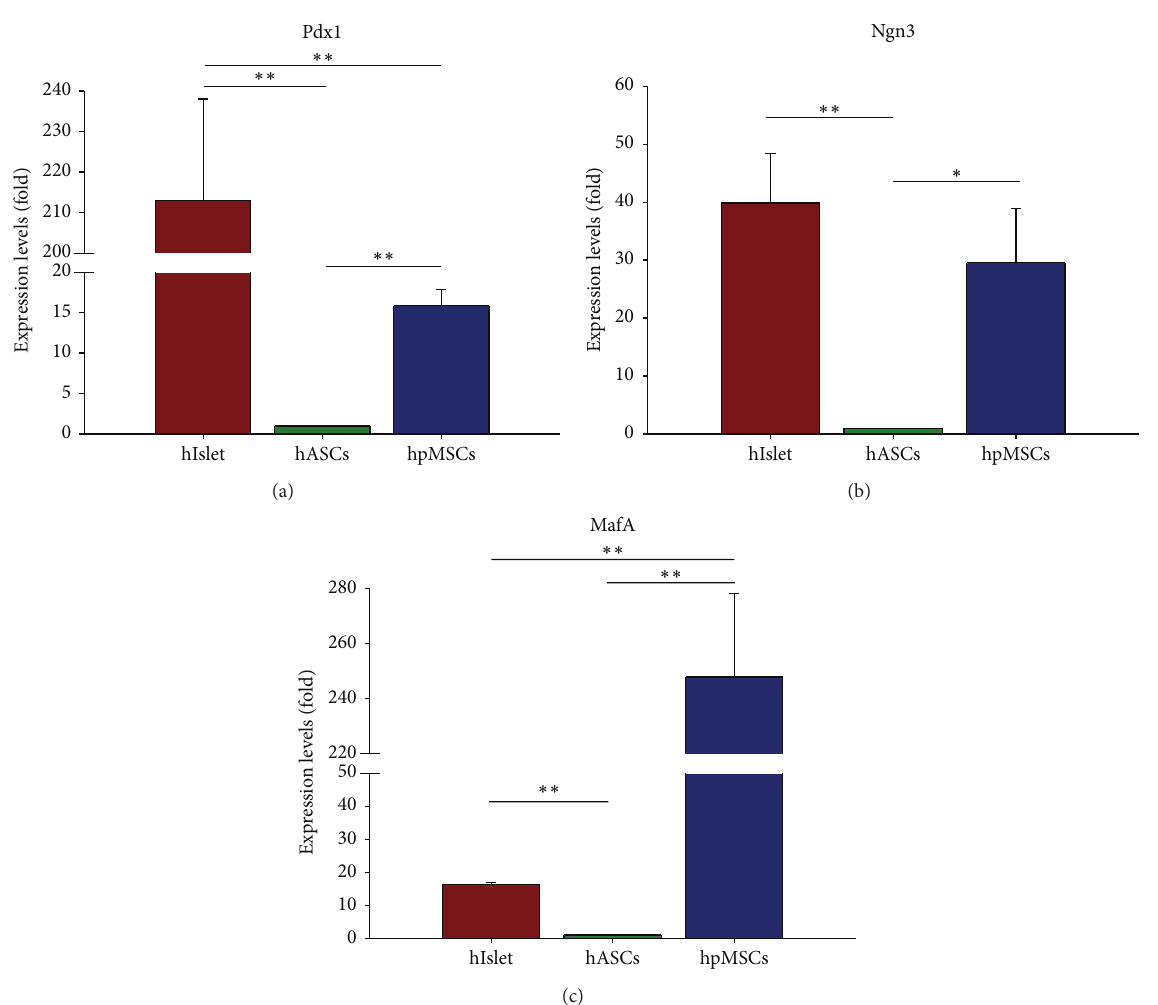
Figure 5: Quantitative analysis of mRNA expression of key pancreatic transcription factors in hpMSCs. Analysis of key pancreatic transcription factors Pdx1, Ngn3, and MafA expression in human islet cells, human ASCs, and hpMSCs by qPCR. Reference expression levels (1-fold) were calculated relative to baseline expression levels measured in hASCs. (a) Pdx1 was highly expressed in islet cells ( 213.040±25.002 ) and hpMSCs ( 15.867±2.019 ), whereas (b) Ngn3 was expressed in both islet cells ( 39.855±8.529 ) and hpMSCs ( 29.535±9.319 ) at comparable levels. (c) MafA was expressed at higher levels in hpMSCs ( 247.826±30.376 ) than in islet cells ( 16.342±0.640 ). Error bars indicate SD ( 𝑛 = 3 ); ∗ 𝑝 < 0.05 ; ∗∗ 𝑝 < 0.005